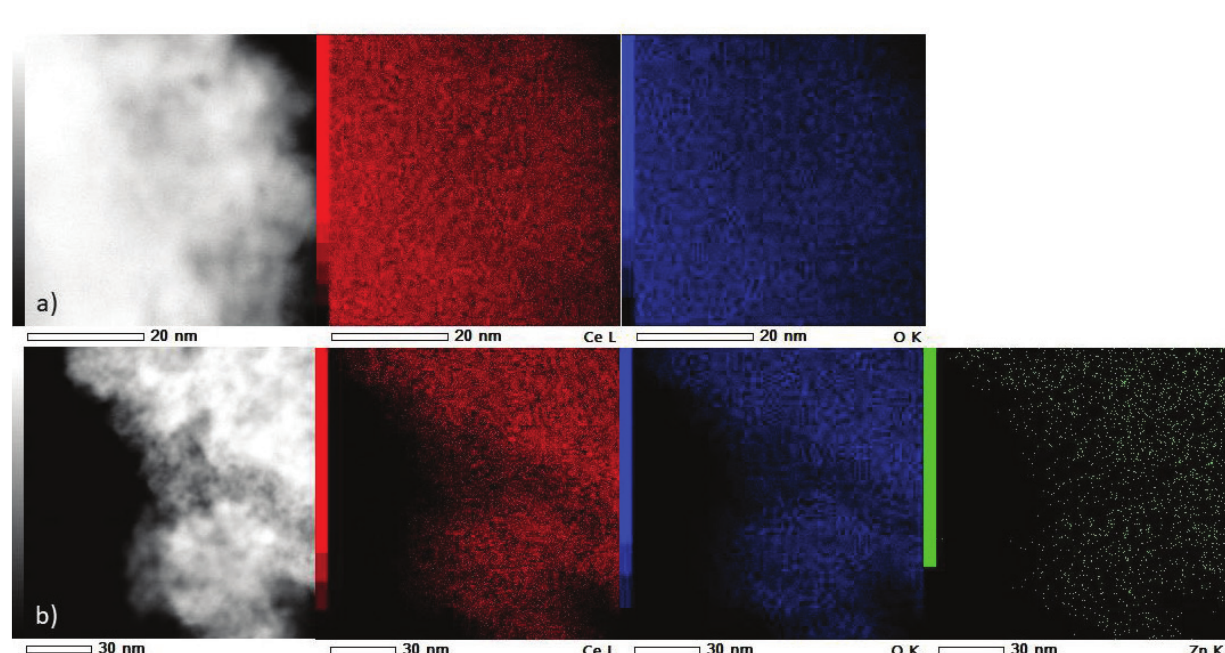
Fig. 2 – STEM-ADF image and EDS mapping of the pure (a) and doped (b)